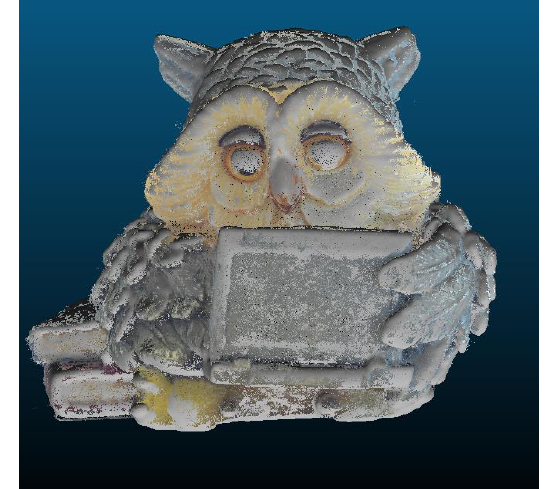
Figure 8: 3D point cloud generated with structured light system